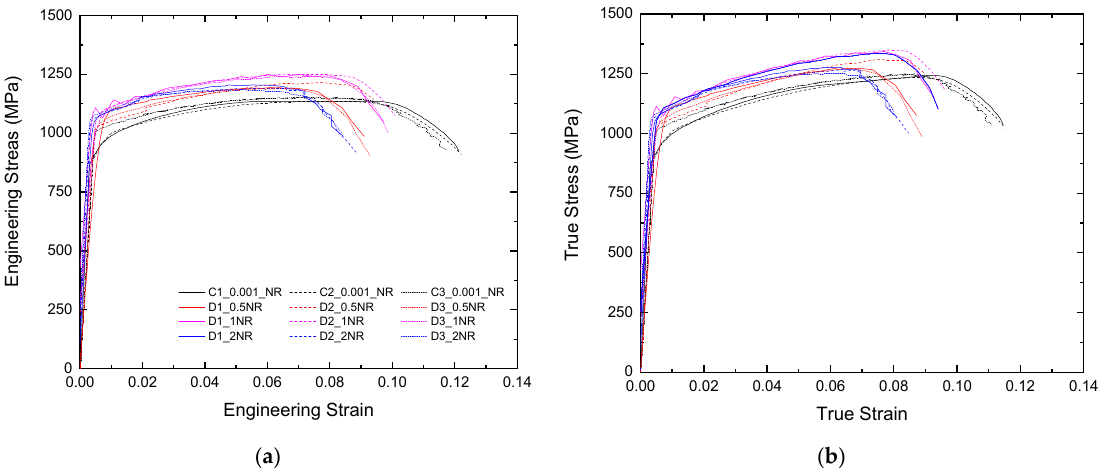
Figure 6. Engineering stress–strain ( a ) and true stress–strain ( b ) curves for uniaxial tensile tests under different strain rates.